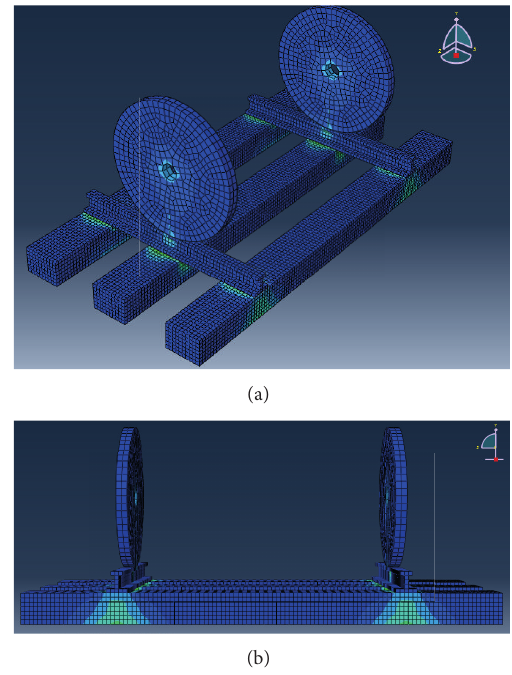
Figure 4: Finite element mesh of wheel-rail-sleeper model.